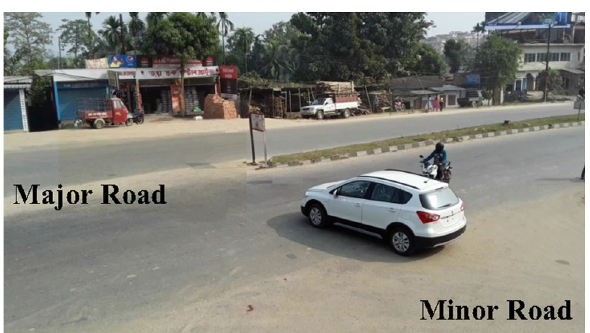
Fig. 7 Forced entry made by the car bringing the two-wheeler to a complete halt